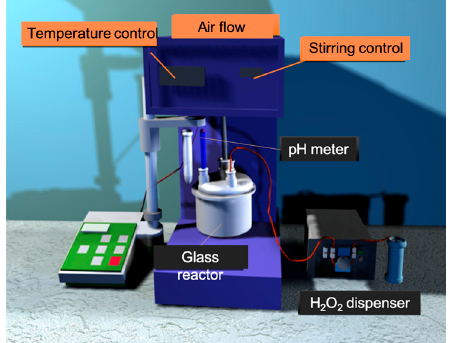
Figure 9. Reactor used for the catalytic degradation of